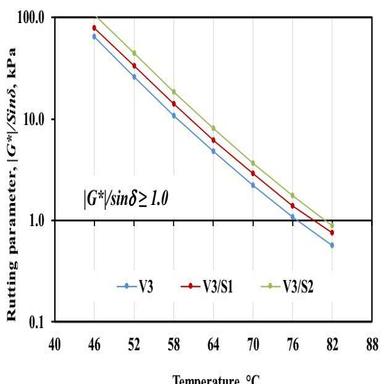
ASTM Ai–VTSi plots for the asphalt binders.